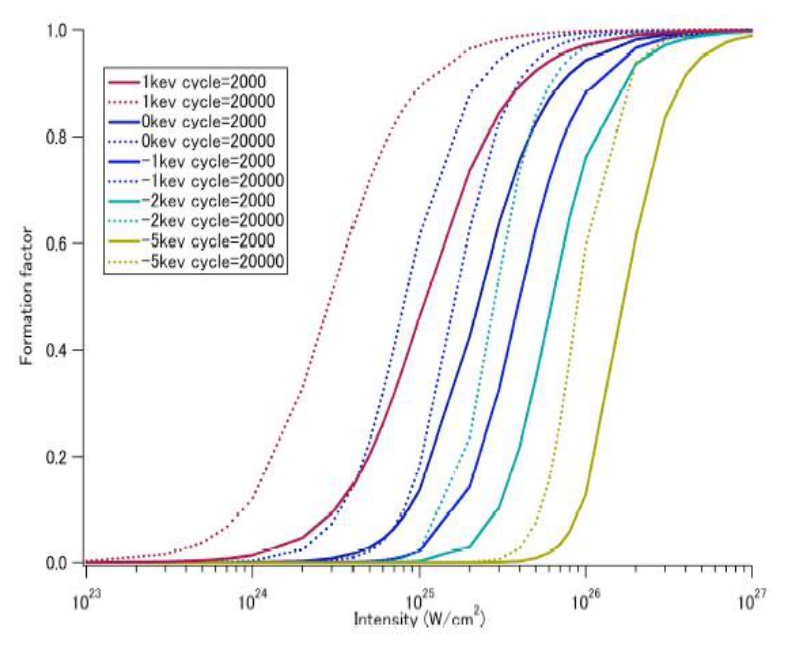
Figure 8. Formation factors of cloud for long pulse